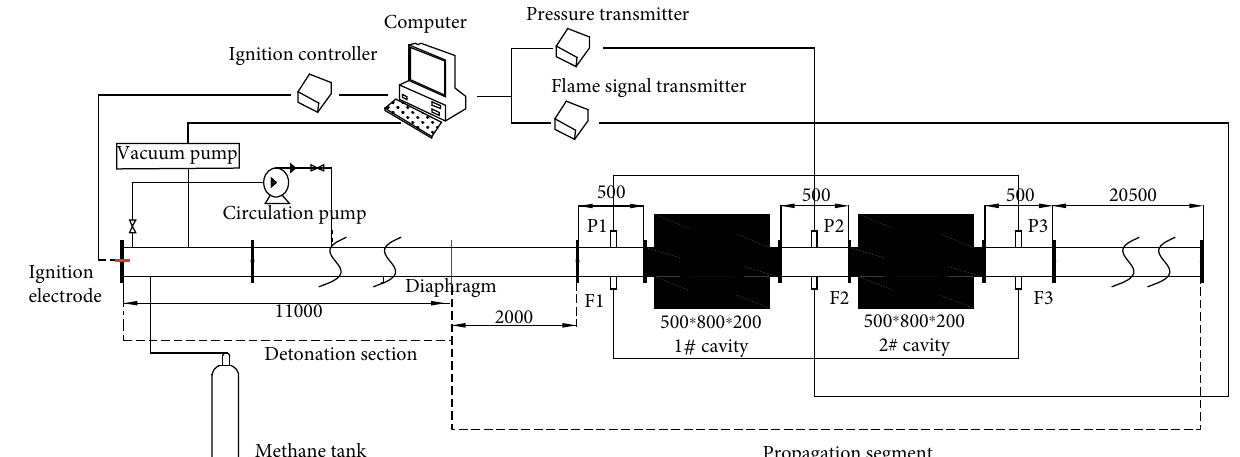
Figure 1: Schematic diagram of the gas explosion test system.